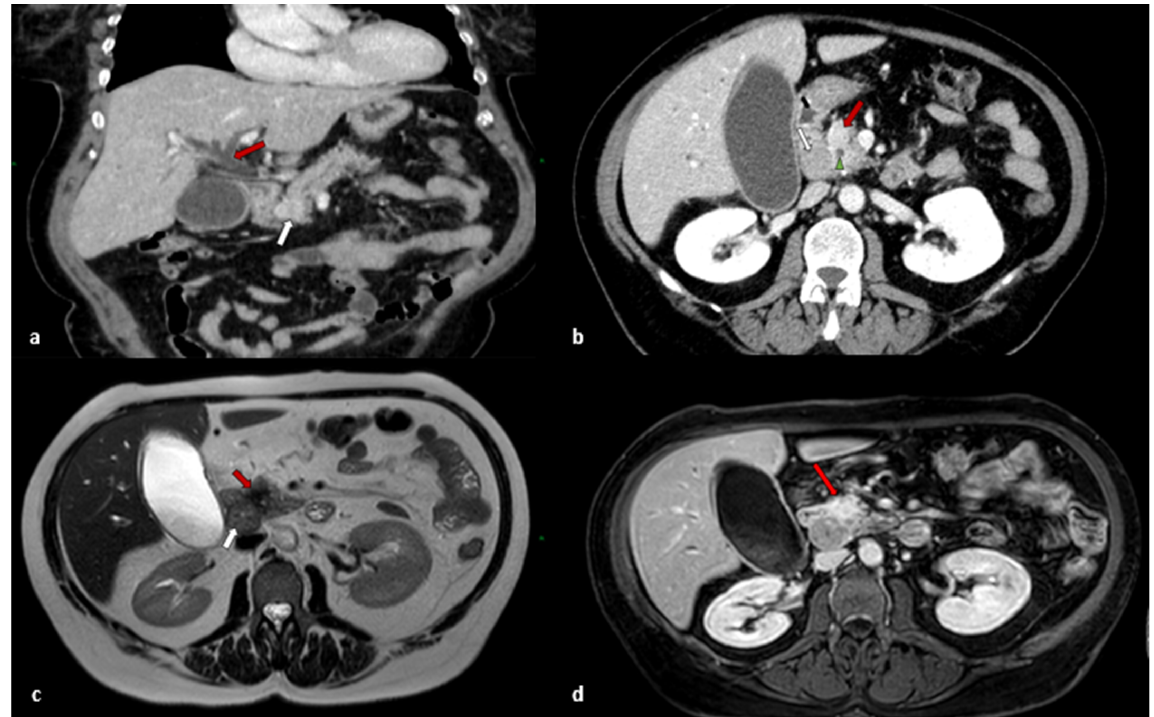
Figure 1. ( a ) Post-contrastographic CT scan coronal view shows inhomogeneous enhanced expansive solid mass with irregular edges localized at pancreatic cephalic portion (white arrow). The mass exerts compressive effect on the duodenum and choledochus, with evident dilatation of extra- and intra-hepatic biliary ducts upstream (red arrow); ( b ) Contrast-enhanced CT scan axial view